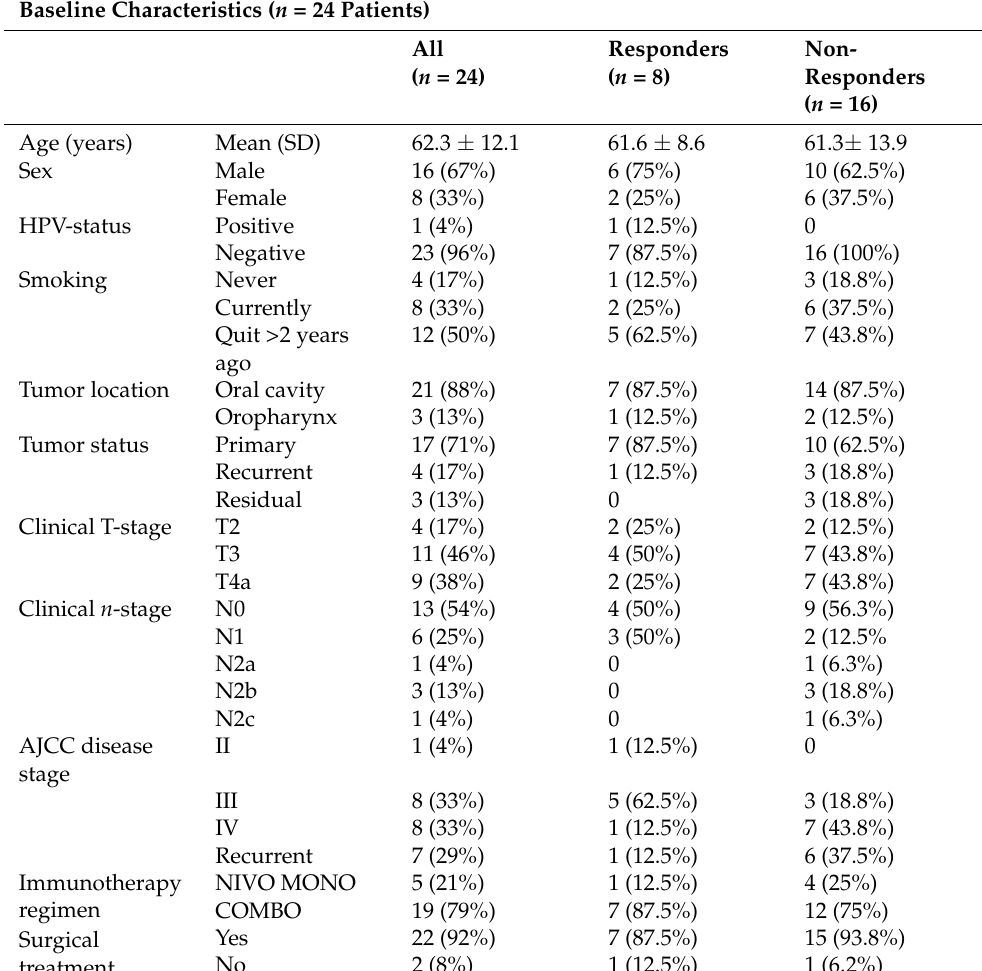
Table 1. HPV: human papillomavirus, OSCC: oropharyngeal squamous cell carcinoma, n : sample size, n : subsample size, AJCC: American Joint Committee on Cancer. NIVO MONO: nivolumab monotherapy, COMBO: combined nivolumab and